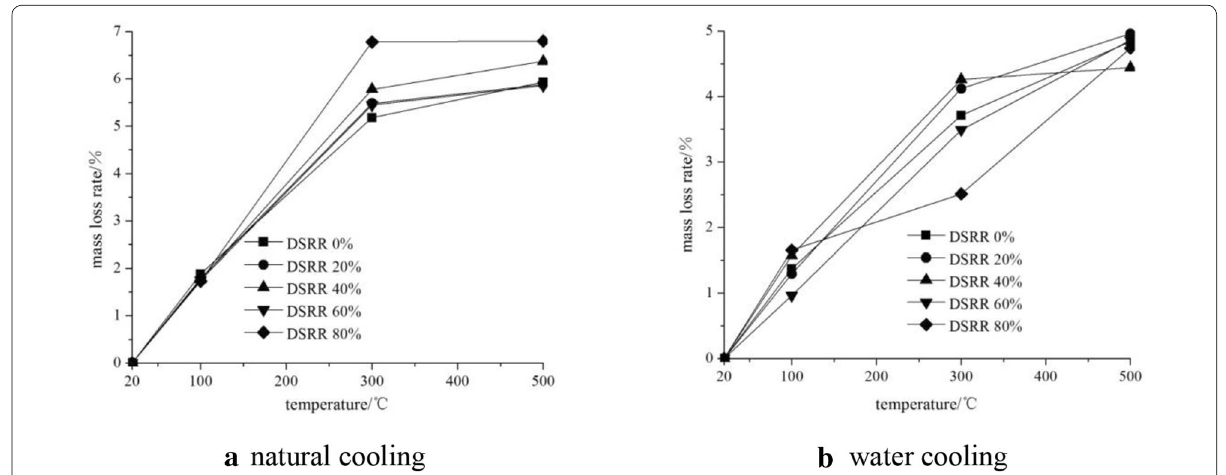
Fig. 8 Relation between the mass loss rate of concrete produced with desert sand and temperature.